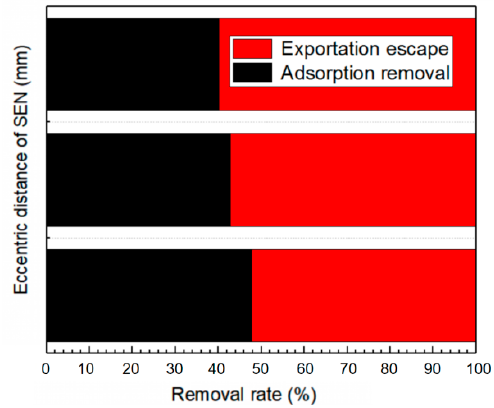
Figure 8. Inclusion removal rates of different SEN eccentric distances.